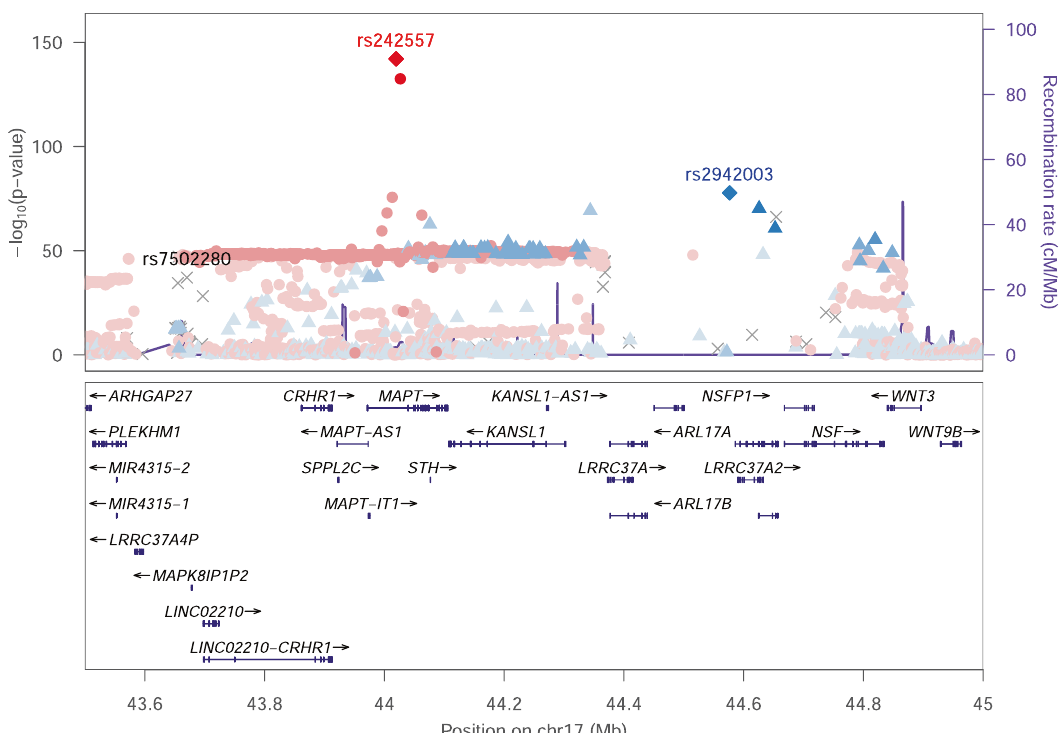
Fig. 3 Regional association plot at the MAPT 17q21 locus. Genetic variants are plotted with their P values (-log10 values, left y axis) as a function of the build 37 genomic position ( x axis). Estimated recombination rates (right y axis) re fl ect the local linkage disequilibrium (LD) structure around the top distinct associated genetic variants (red and blue diamonds, denoting rs242557 and rs2942003, respectively), identi fi ed using stepwise model selection procedure, and their correlated proxies. Genetic variants in LD with rs242557 are indicated with circles according to a light to dark red scale, from r² = 0 to 1. Genetic variants in LD with rs2942003 are indicated with triangles according to a light to dark blue scale, from r² = 0 to 1. Gray crosses (X) represent SNPs with missing LD. The third distinct genetic variant (rs7502280), indicated in black on the plot, was not present in the reference panel to calculate the LD with the other variants in the region. Reference panel used was the 1000 Genomes November 2014 European population.